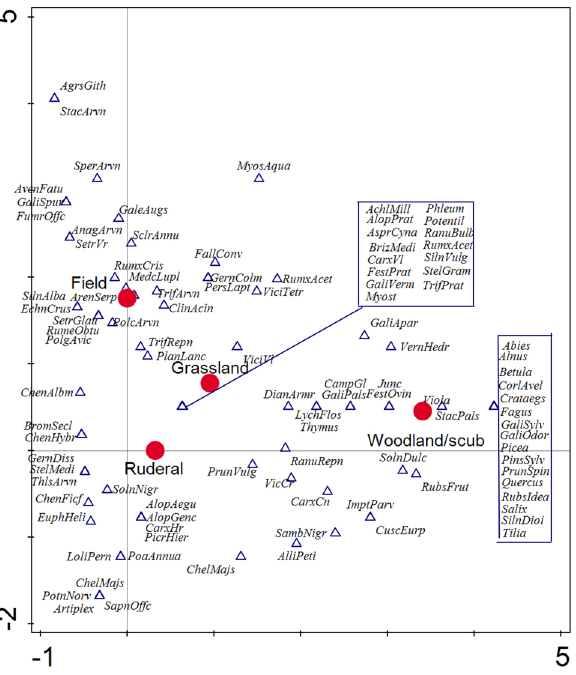
Figure 8. Březnice: detrended correspondence analysis (DCA) Displayed samples and botanical taxa: the first axis explains 44.57% variability, the first and the second axis together